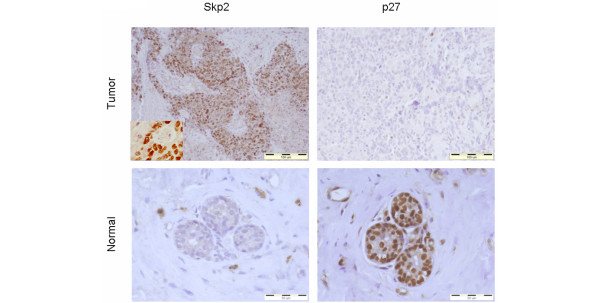
Representative immunohistochemistry slides for Skp2 and p27Kip1 staining in locally advanced breast cancer. Tumor cells of pretreated grade II invasive duct cancer (T3N1MO) exhibiting strong and diffuse nuclear staining for Skp2 and low staining of p27Kip1 (upper row and insert). Note the inversely low Skp2 staining followed by high p27Kip1 staining in normal breast tissue (lower row). KIP, kinase inhibitor protein; Skp2, S-phase kinase protein 2.